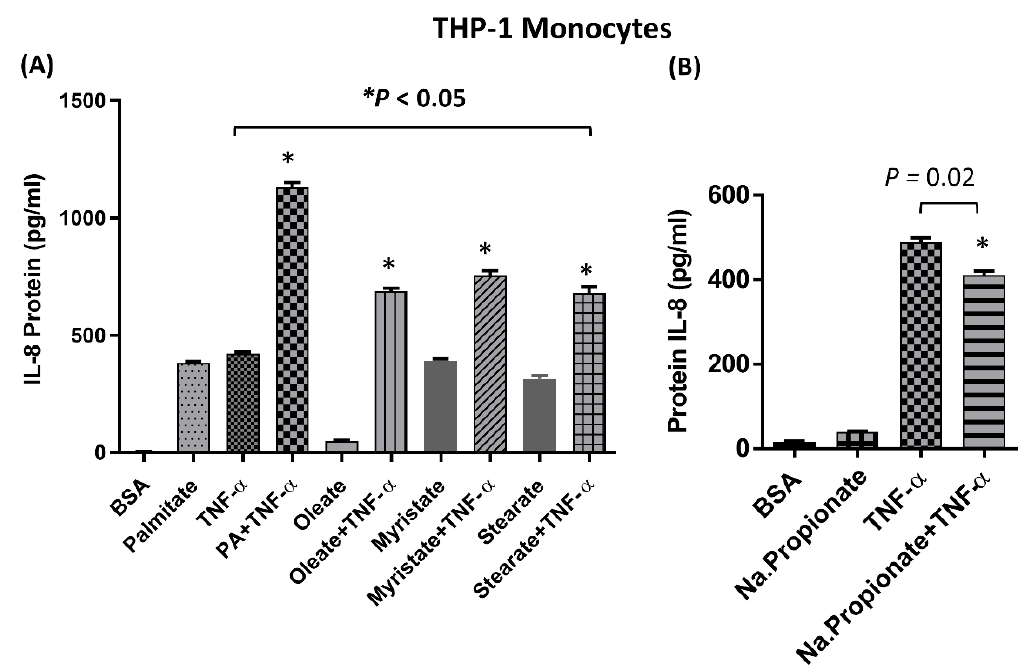
Figure 2. Effect of different fatty acids combined with TNF- α for IL-8 production. ( A ) THP-1 cells were treated for 24 h with different long chain free fatty acids (FFAs) alone or in combination with TNF- α . IL-8 protein was quantified in culture media by ELISA. ( B ) Monocytes were treated with the short chain fatty acid propionate alone or in combination with TNF- α , and IL-8 protein secretion was quantified by ELISA. The results obtained from three replicates of each experiment are shown. Data are expressed as mean ± SEM. * Indicates significant difference.